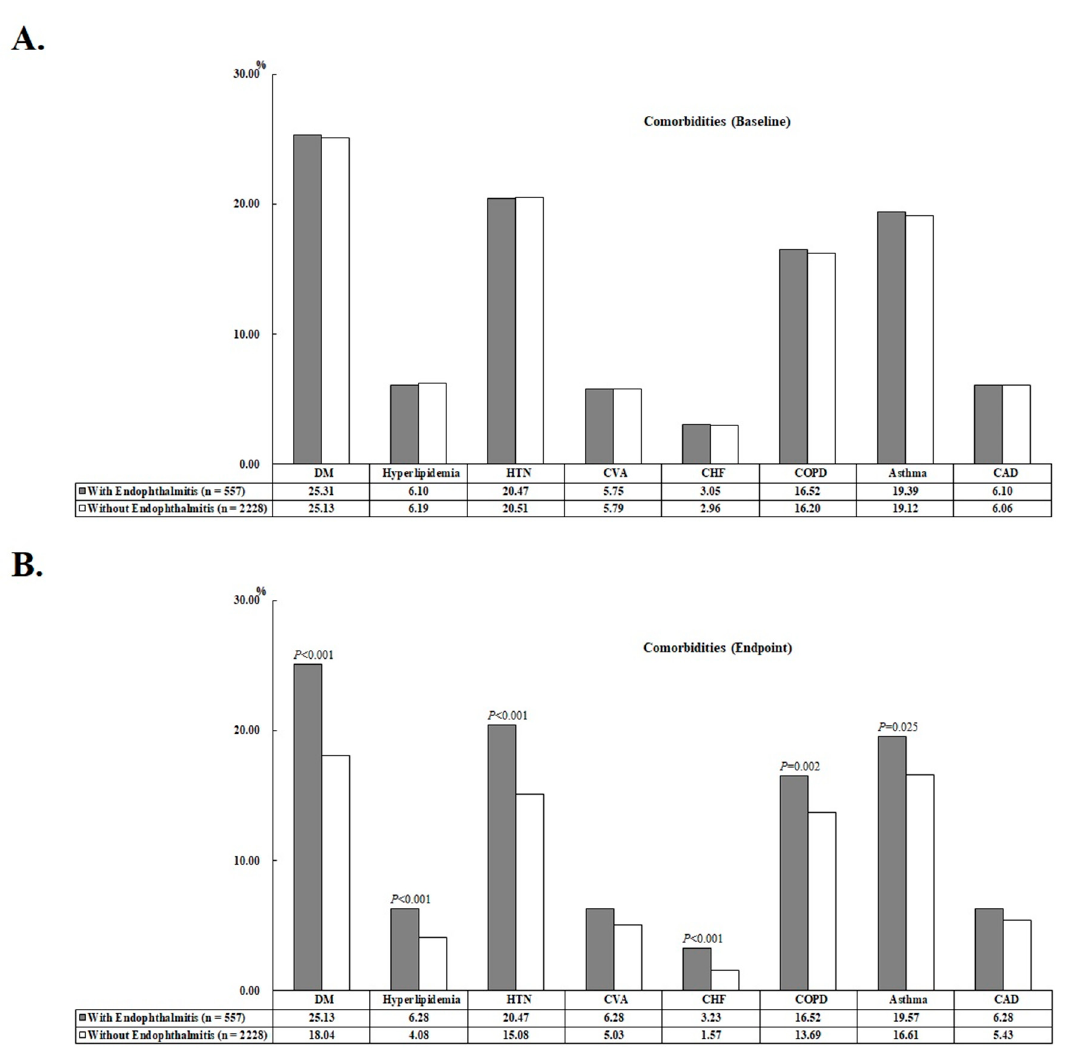
Figure 2. Bar chart of the comorbidities of the enrolled patients at baseline ( A ) and at the study endpoint ( B ). Table 1. Demographic and medical characteristics of enrolled AS patients with and without en- dophthalmitis at the endpoint of the study.